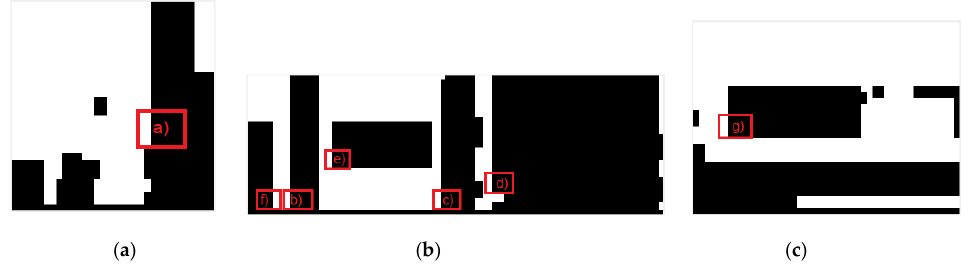
Figure 19. Patterns detected in doors/windows listed. ( a ) First wall. ( b ) Second wall. ( c ) Third wall. Table 4. Variance and area calculated for each pattern detected.